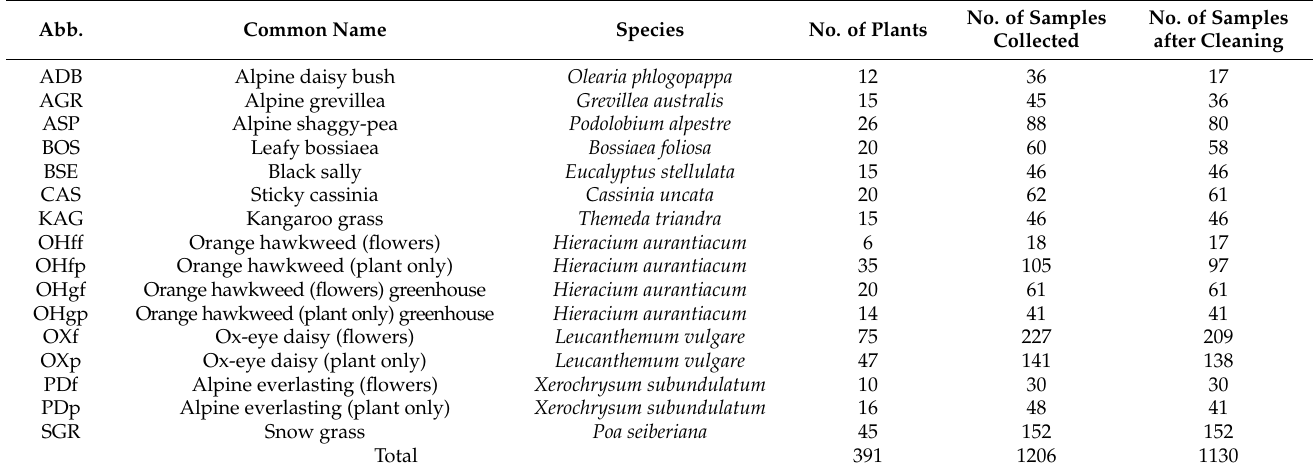
Table 1. Summary of the 11 species sampled using optical lens in the first field survey conducted in January 2017. The total number of plants and total number of samples before and after the removal of outliers are listed.